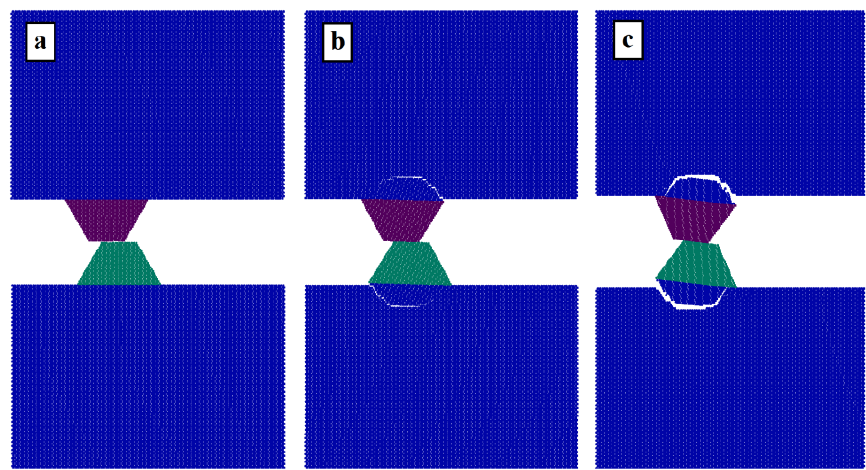
Fig. 2. Evolution of the asperities detachment in the “breakaway” regime of wear